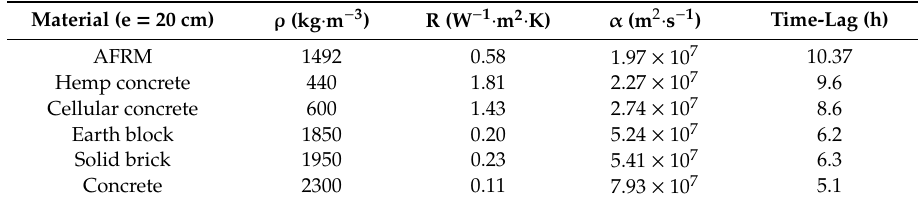
Table 4. Comparison between the time-lag of AFRM 5% material and those of other materials presented in the literature.